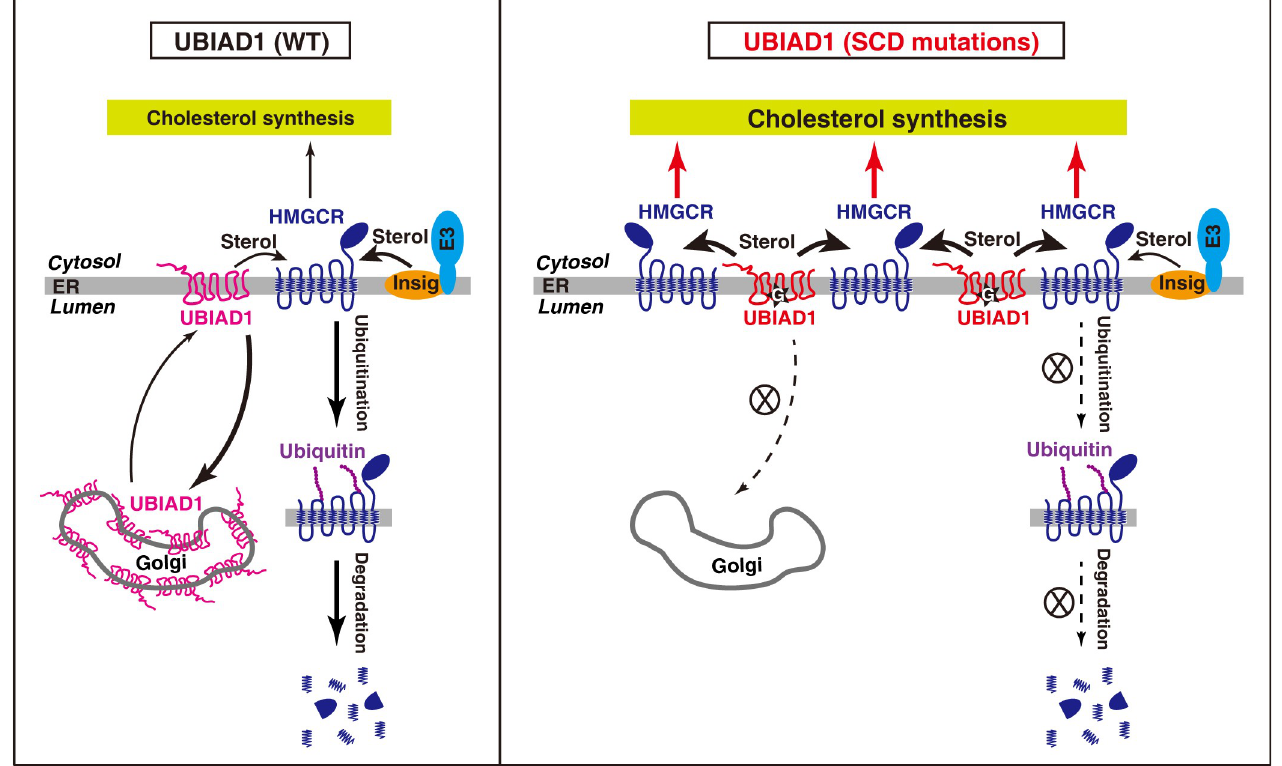
Fig 8. Schematic illustration of the role of UBIAD1 in sterol-accelerated degradation of HMGCR. Sterols induce ER-anchored Insig to bind HMGCR, which is ubiquitinated by Insig-associated E3 ubiquitin ligase (gp78, Trc8, or RNF145), leading to the degradation of HMGCR. In contrast to WT UBIAD1 that is efficiently transported to Golgi from ER. SCD-associated mutant UBIAD1s are sequestered in ER. They compete with Insig to bind HMGCR, inhibit the ubiquitination and degradation of HMGCR. Thus, UBIAD1 mutants increase cholesterol biosynthesis and cause cholesterol accumulation in the cornea.